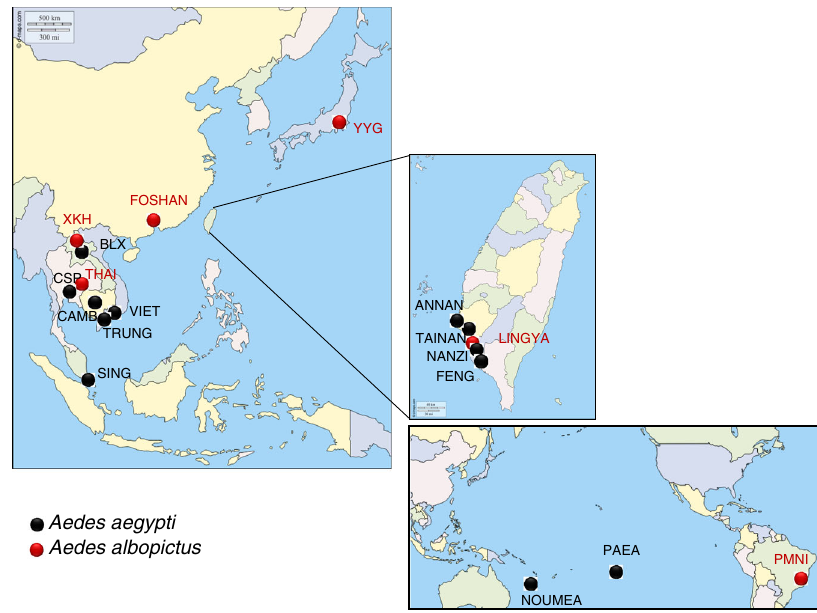
Fig. 6 Geographical distribution of the 18 mosquito sample locations (12 Aedes aegypti and 6 Aedes albopictus ). Black dots: Aedes aegypti ; red dots: Aedes albopictus . The map was built using the open-source map site “ https://d-maps.com/conditions.php?lang = en/ ” . Each dot corresponds to a sampling